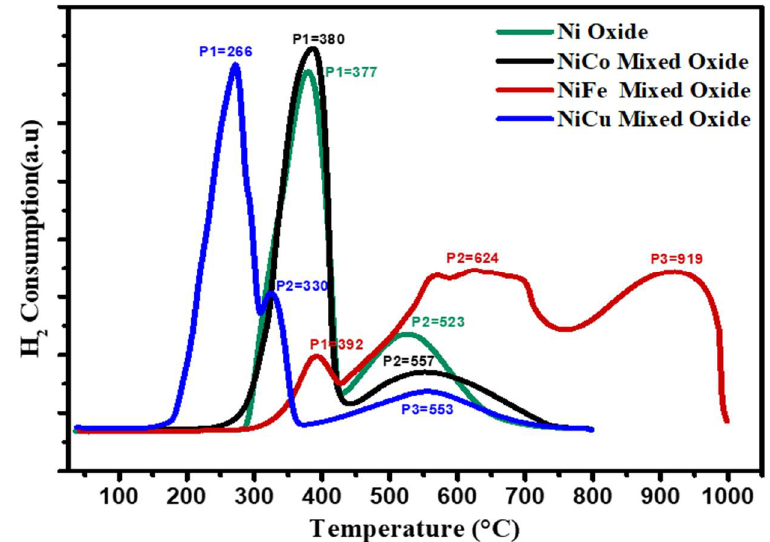
Figure 2. TPR profiles of the fresh samples Ni, Ni-Co, Ni-Fe, and Ni-Cu.